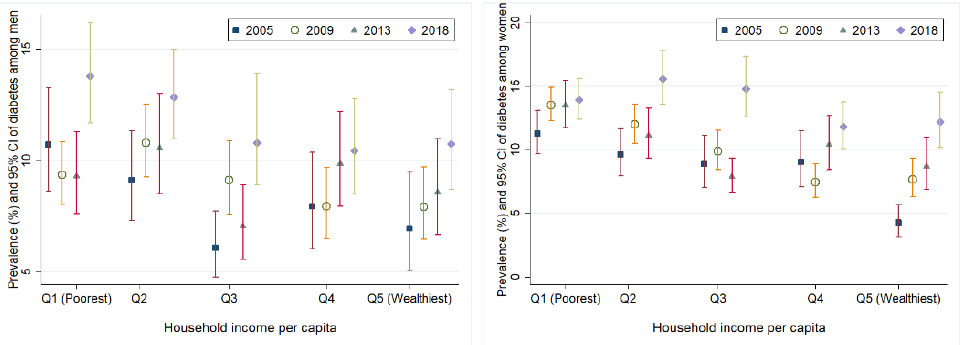
Figure 2. Prevalence of diabetes according to sex and household income per capita. In the inequalities analysis, the ECIs for the general urban Argentinian population